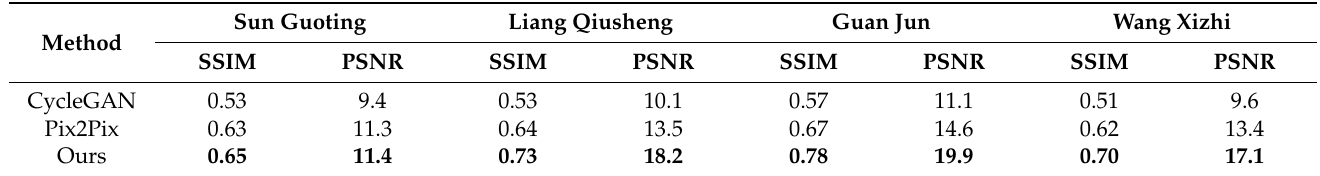
Table 4. Quantitative evaluations of our method and other two